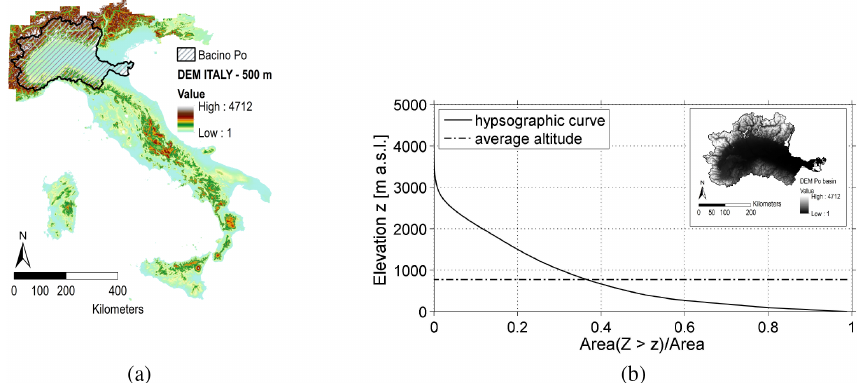
Figure 3. (a) DEM of Italy at 500m spatial resolution with the contour line of the Po River basin. (b) Hypsographic curve of the Po River basin derived from the